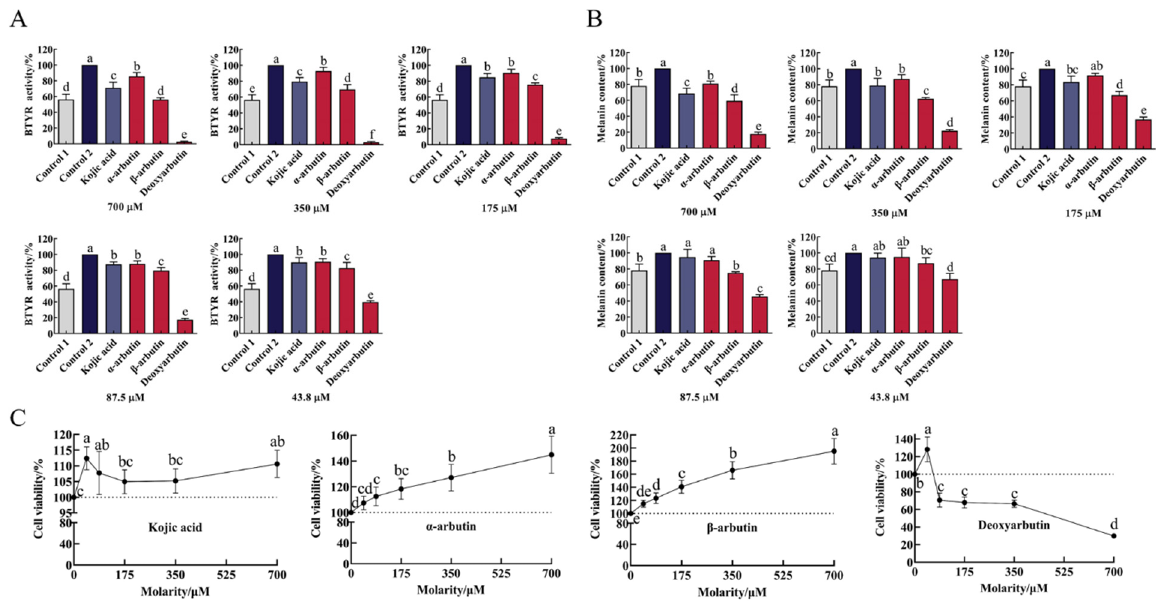
Figure 5. Effect of four compounds on tyrosinase activity, melanin content and cell viability of B16F10 cells. ( A ) Effect of four compounds on BTYR activity; ( B ) Effect of four compounds on melanin content; ( C ) Effect of four compounds on cell viability. Control 1 was blank group, while control 2 was control